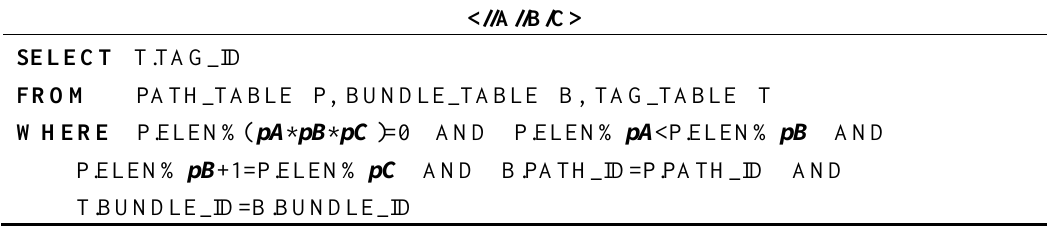
Table 7. SQL statements of Q2.